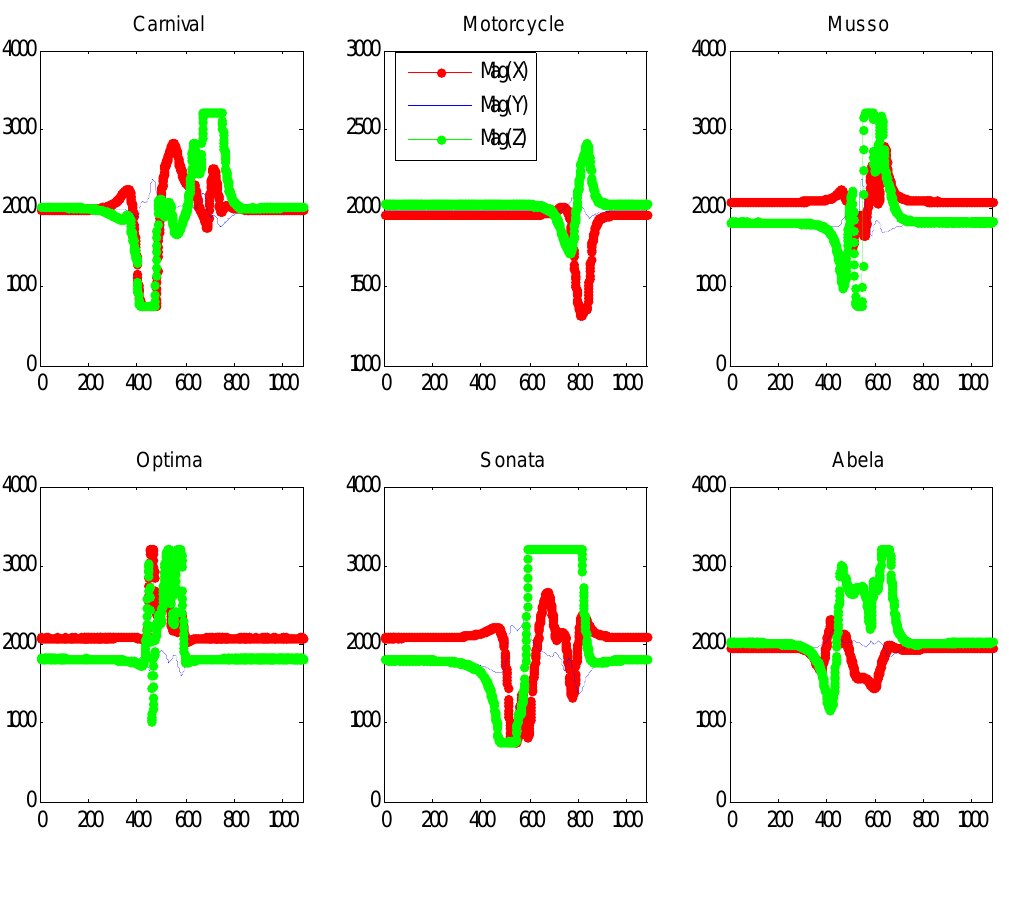
Figure 8. Magnetic Field distortion by different vehicles. Carnival is a kind of van, and Musso is a kind of SUV. The others are categorized as passenger cars.